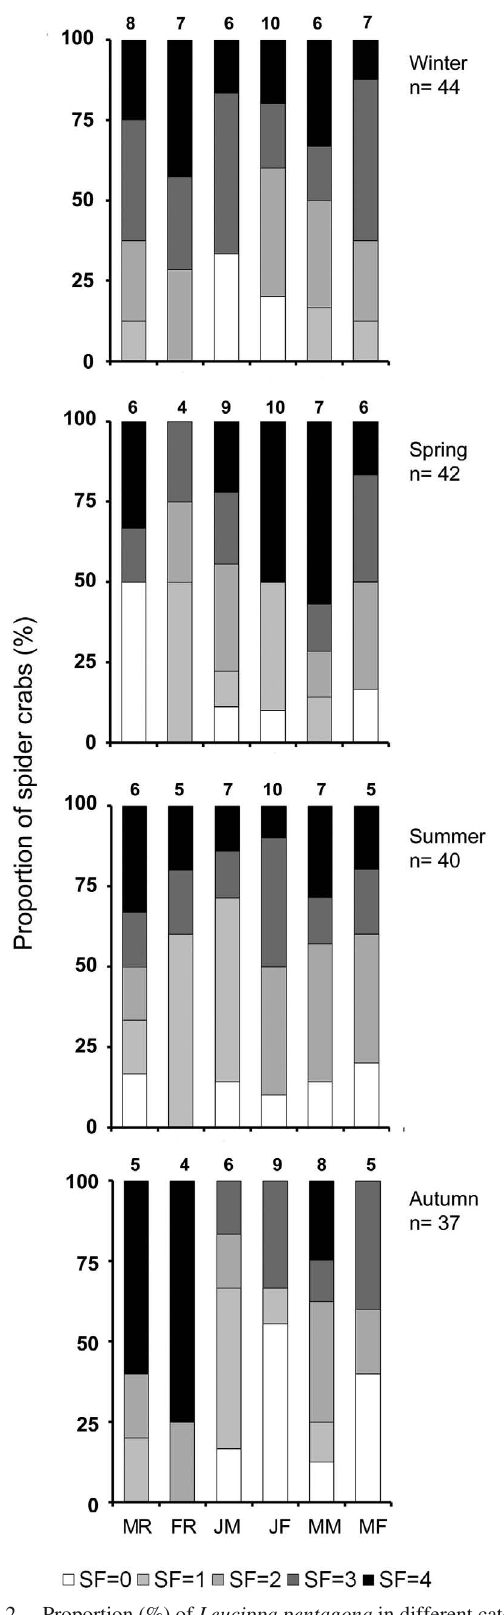
Fig. 2. – Proportion (%) of Leucippa pentagona in different catego- ries of stomach fullness (SF). MR male recruits, FR female recruits, JM juvenile males, JF juvenile females, MM mature males, MF mature females. Numbers on the top refer to number of specimens in each